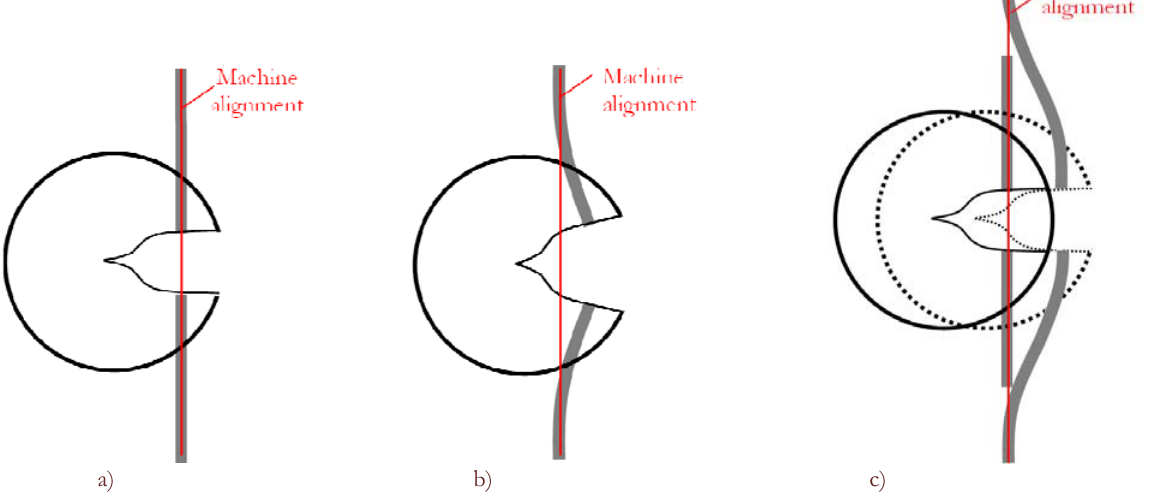
Figure 10: Schematic representation of the opening mechanism of the notch: a) parallel opening, b) angular opening and c) transversal displacement of the specimen during testing by parallel opening.